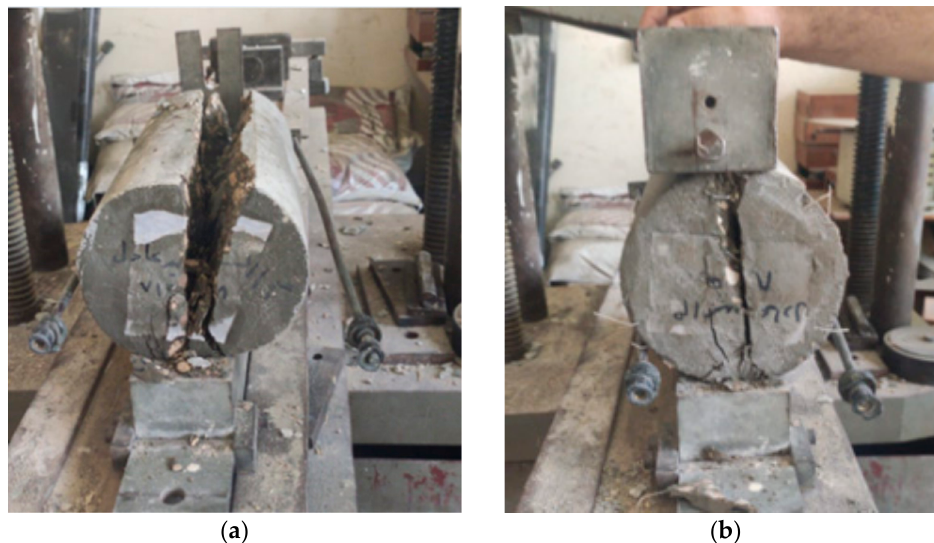
Figure 8. The fracture sample morphology: ( a ) failed PCC specimen; ( b ) failed MSFRC specimen.